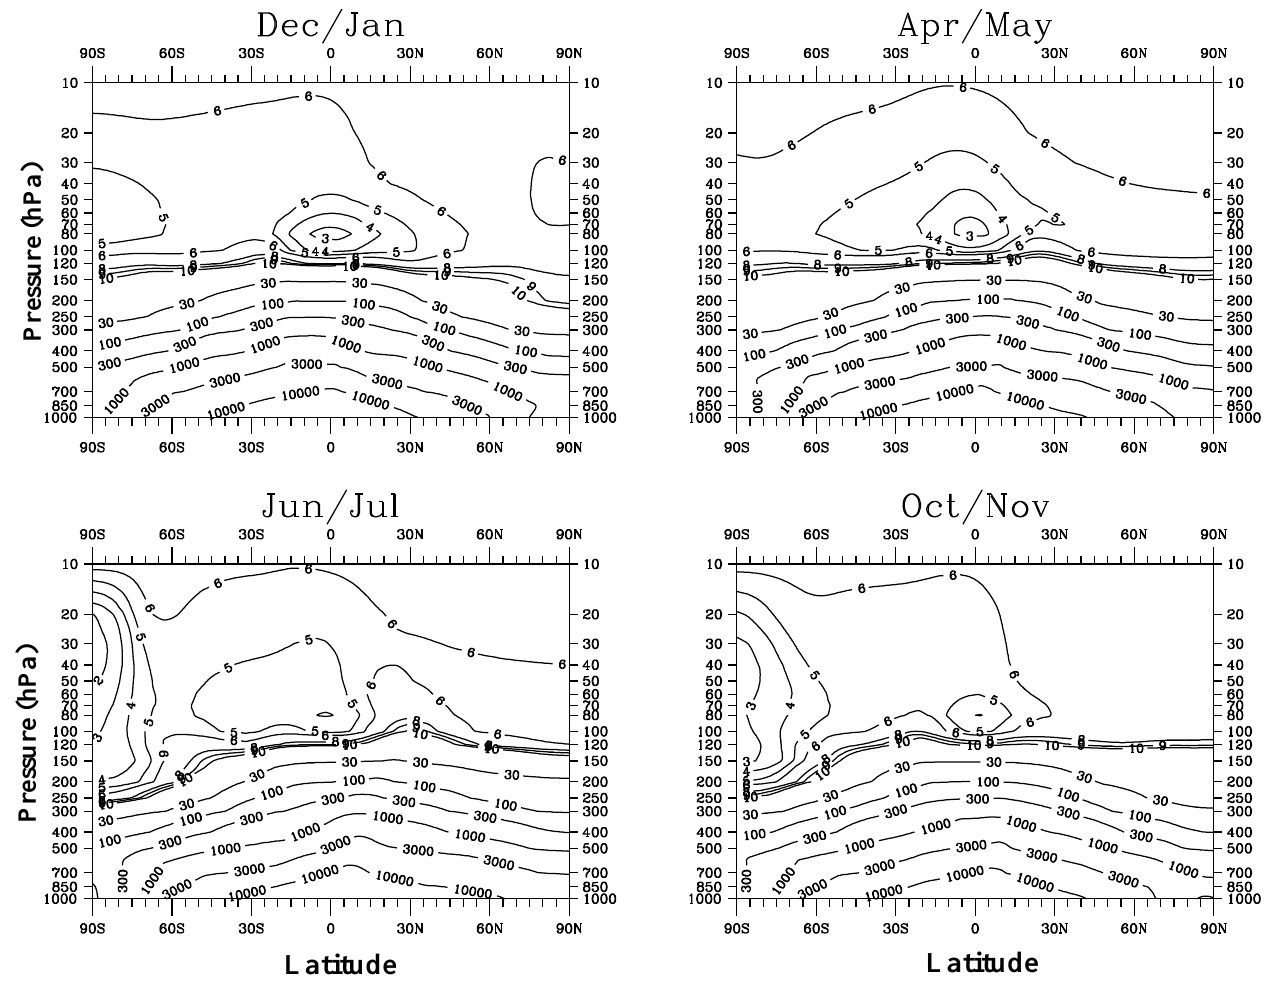
Fig. 13. Monthly averages of the zonal mean water vapour mixing ratios (ppmv) averaged over 20 years for December/January, April/May, June/July, and October/November, as simulated by